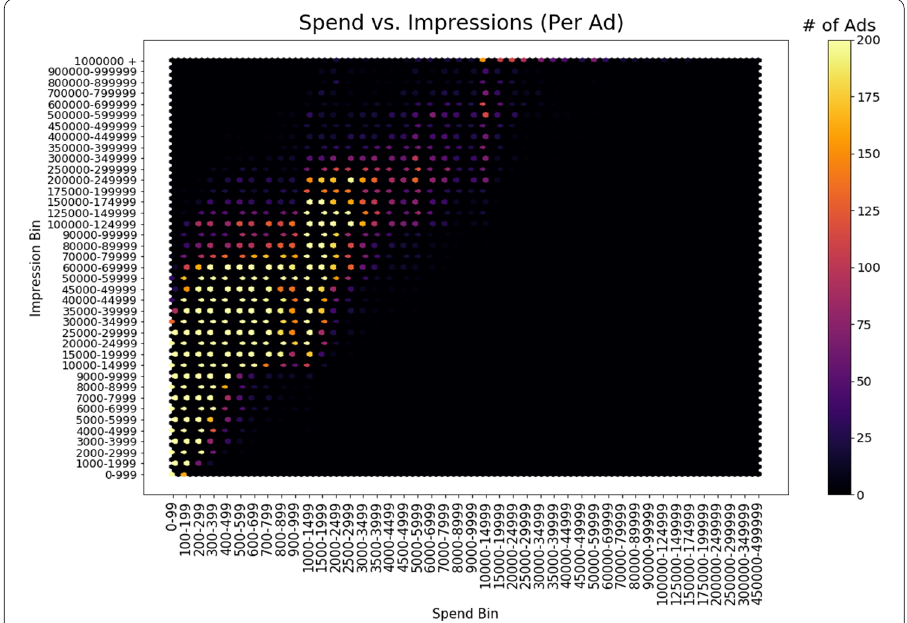
Fig. 2 Heat map of each ad’s spend bin (x value) versus its impression bin (y value); the color bar refers to the number of ads with the corresponding (x,y) value. Notice the variant bin sizes (inter-axis and intra-axis),